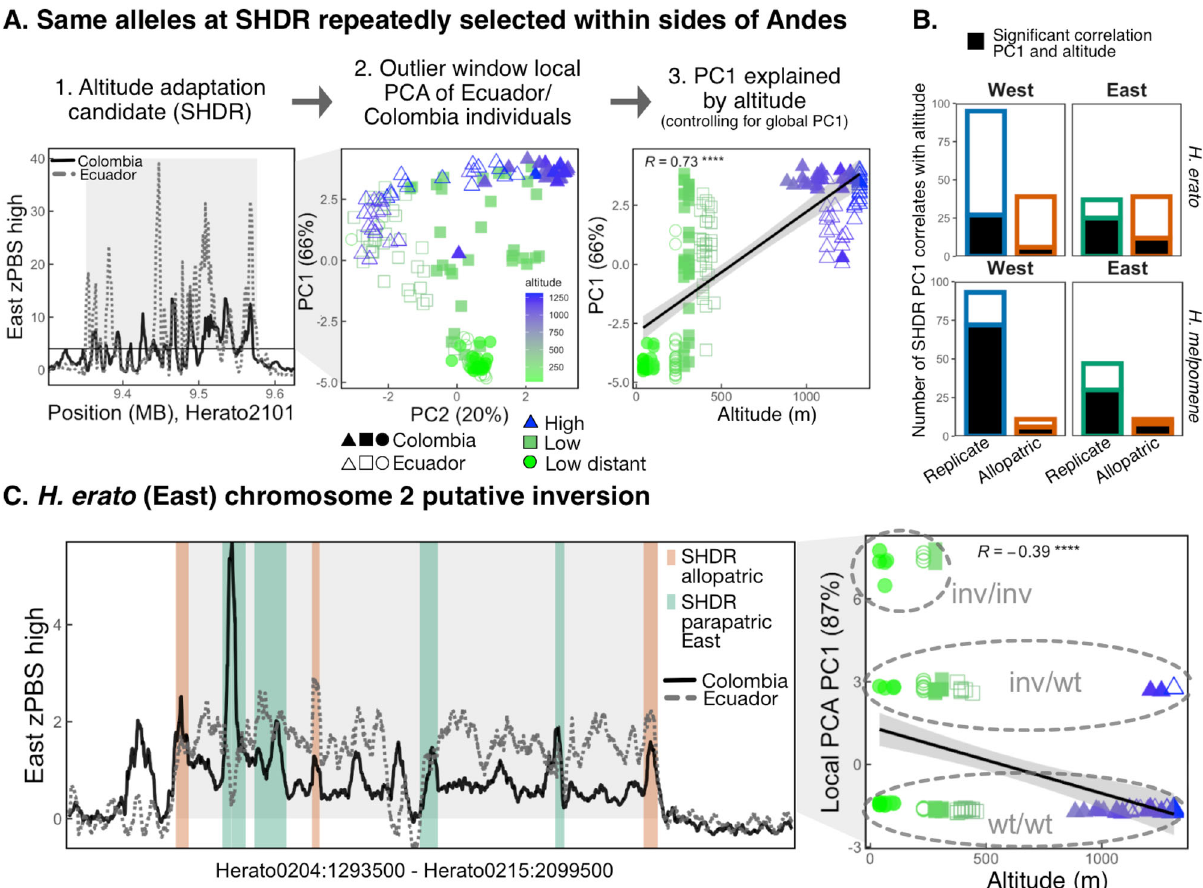
Fig.5|AllelesharingSHDRsandlargeputativeinversioninchromosome2of H. erato Eastern transects. A Example analysis to test whether same alleles underlie SHDRs(heredepicted H.erato EasternSHDR#77).First,outlierwindows(zPBS>4) in either the Eastern Colombia (solid black line) or the Eastern Ecuadorian (dotted grey line) transect are selected (grey panel), and a local PCA with those sites is performed. Then we test whether PC1, the axis explaining most of the variation, is signi fi cantly explained by the altitude at which individuals were collected, while controlling for the global PC1 (i.e., neutral population structure). Each point represents an individual, theirshape represents transectoforigin(Colombia fi lled, Ecuadoremptysymbols)andtheircolourthealtitude(m)atwhichindividualswere collected. The solid line represents the best fi t of a linear model, with the shaded area showing a con fi dence bands at 1 standard error and the Pearson correlation coef fi cient is shown (R, P<2.2e − 16 ). B Number of SHDRs where altitude is a sig- ni fi cant predictor of local PCA axis 1. C zPBS highland differentiation in Eastern